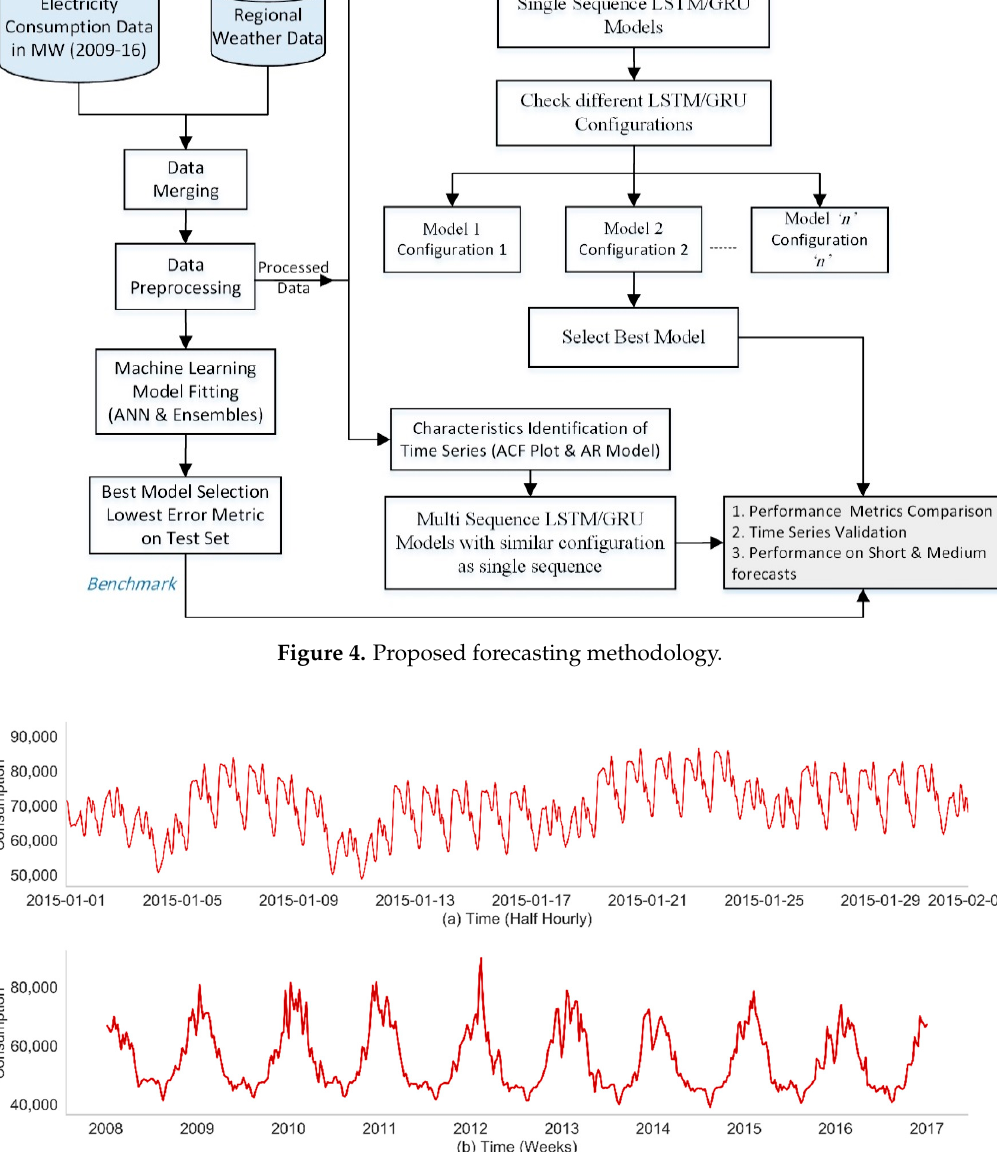
Figure 5. Electricity load versus time: daily, weekly and monthly patterns. ( a ) Half hourly consumption; ( b ) Weekly Consumption; ( c ) Monthly Consumption.